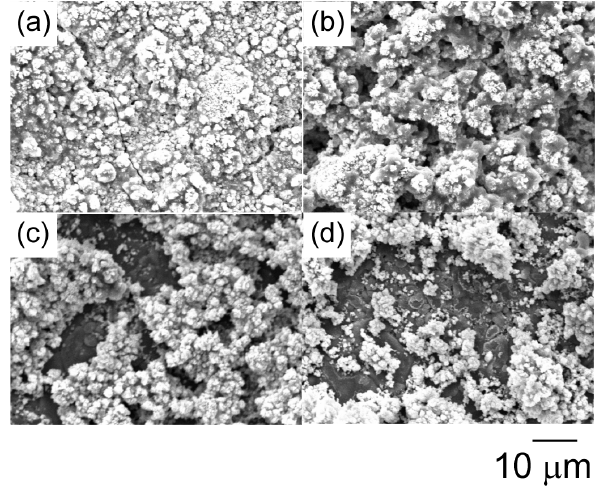
Figure 2. SEM images of the auxiliary sensing electrodes obtained by heating 0.7La 2 O 2 SO 4 − 0 . 3(0.8Li 2 SO 4 + 0 . 2K 2 SO 4 ) with (a) 0wt%, (b) 10wt%, (c) 30wt%, or (d) 50wt% PMMA on the Zr 39 / 40 TaP 2 . 9 W 0 . 1 O 12 solid electrolyte.